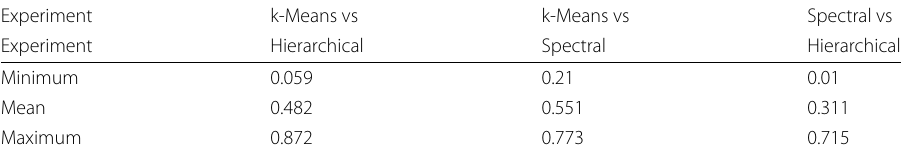
Table 10 Summary of the adjusted mutual information between all pairs of clustering methods presented for each experiment Experiment k-Means vs k-Means